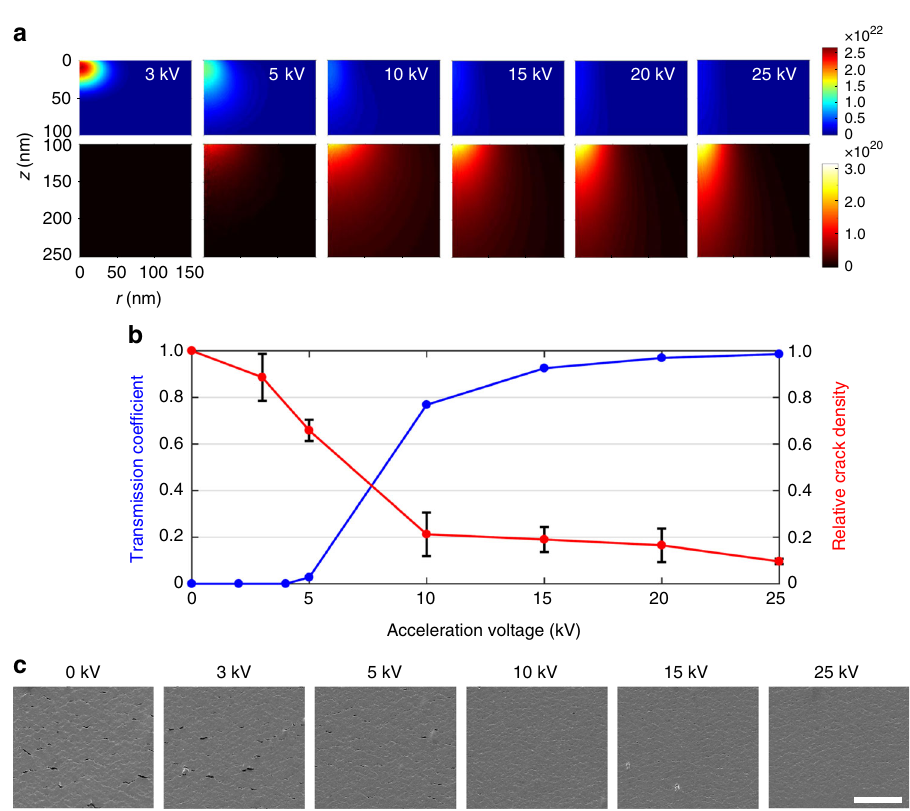
Fig. 3 Computational and experimental investigation of the dependence of crack suppression on the acceleration voltage ( V A ). a Distribution of the energy of the irradiated electrons absorbed in the Cu fi lm – PI system at different values of V A ranging from 3 kV to 25 kV. The absorbed energy in the Cu fi lm (0 nm ≤ z ≤ 100 nm) and the PI substrate (100 nm ≤ z ≤ 250 nm), in unit of keV m − 3 ·electron, was calculated using the CASINO Monte Carlo software. b Transmission coef fi cients (de fi ned as the ratio of the number of electrons transmitted through the Cu thin fi lm to that of the total incident electrons) as a function of V A obtained from the Monte Carlo calculation (left, blue). Also shown in b is the relative crack densities at a tensile strain of 30% (right, red) experimentally determined from the SEM images shown in c . Error bars represent the standard deviations. Scale bar, 5 μ